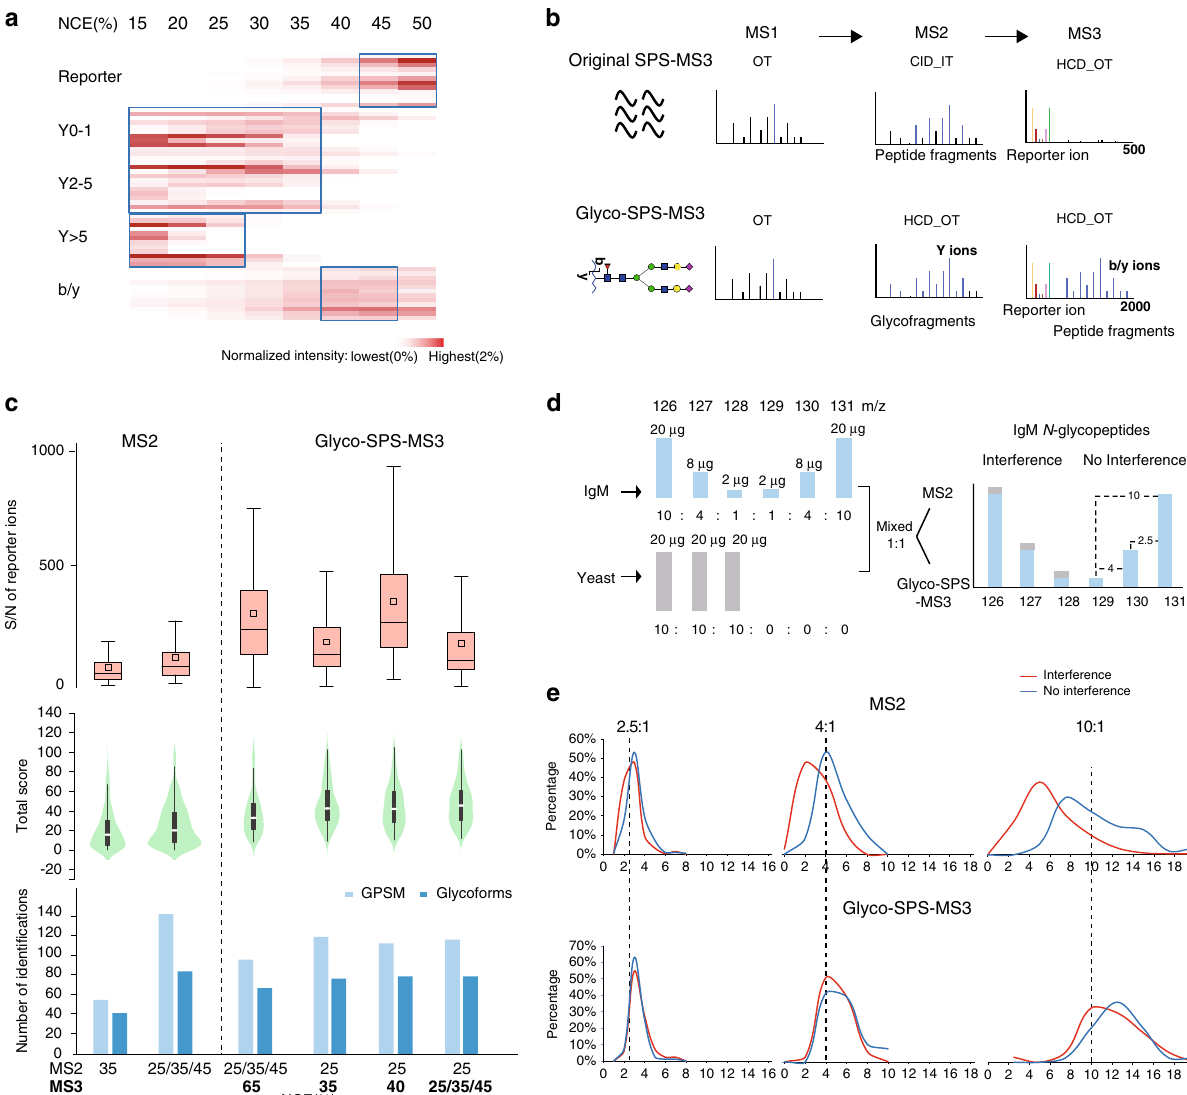
Fig. 2 Glyco-SPS-MS3 method for con fi dent glycopeptides identi fi cation and accurate quanti fi cation. a A heatmap showing normalized intensities of different product ion types (see Supplementary Fig. 3 for nomenclature) of 12 TMT-labeled IgM glycopeptides detected in MS2 experiments using various NCEs. Optimal NCEs for individual product ion types were highlighted with blue boxes. b Schematic work fl ows of the original SPS-MS3 as compared with Glyco-SPS-MS3. Ions being selected for MS2 or MS3 fragmentation are in blue. TMT reporter ions are in red. MS detectors and fragmentation modes used in the methods are shown (IT for ion trap and OT for Orbitrap). c Comparisons of the distributions of TMT-reporter S/N ratios (upper panel, n = 116, 306, 181, 226, 206, and 218), pGlyco total score of GPSMs (middle, n = 336, 504, 188, 233, 219, and 227) and the number of identi fi cations (bottom) obtained using MS2 or Glyco-SPS-MS3 methods with varied NCE settings. n = 2 independent measurements of TMT-labeled IgM glycopeptides. Boxplots show the median (centerline), mean (squares), fi rst and third quartiles (box edges) and 1.5× the interquartile range (whiskers). Outliers are not shown. d Preparation of the IgM-yeast mixture and anticipated outcome of interfered glycopeptide quanti fi cation due to precursor co-isolation. e Determined reporter ion ratios of IgM glycopeptides from the IgM-yeast mixture using MS2 or Glyco-SPS-MS3 methods. Channels with and without yeast interference are shown in blue and red, respectively. Predicted ratios are indicated. Source data are provided as a Source Data fi